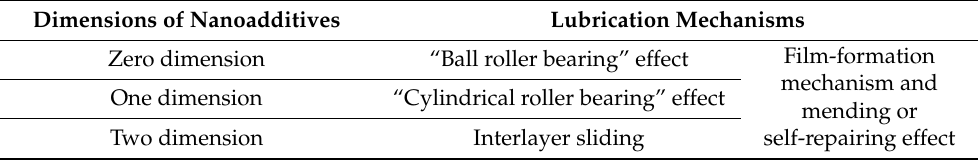
Table 3. Lubrication mechanism of nanolubricant additives in different dimensions. Dimensions of